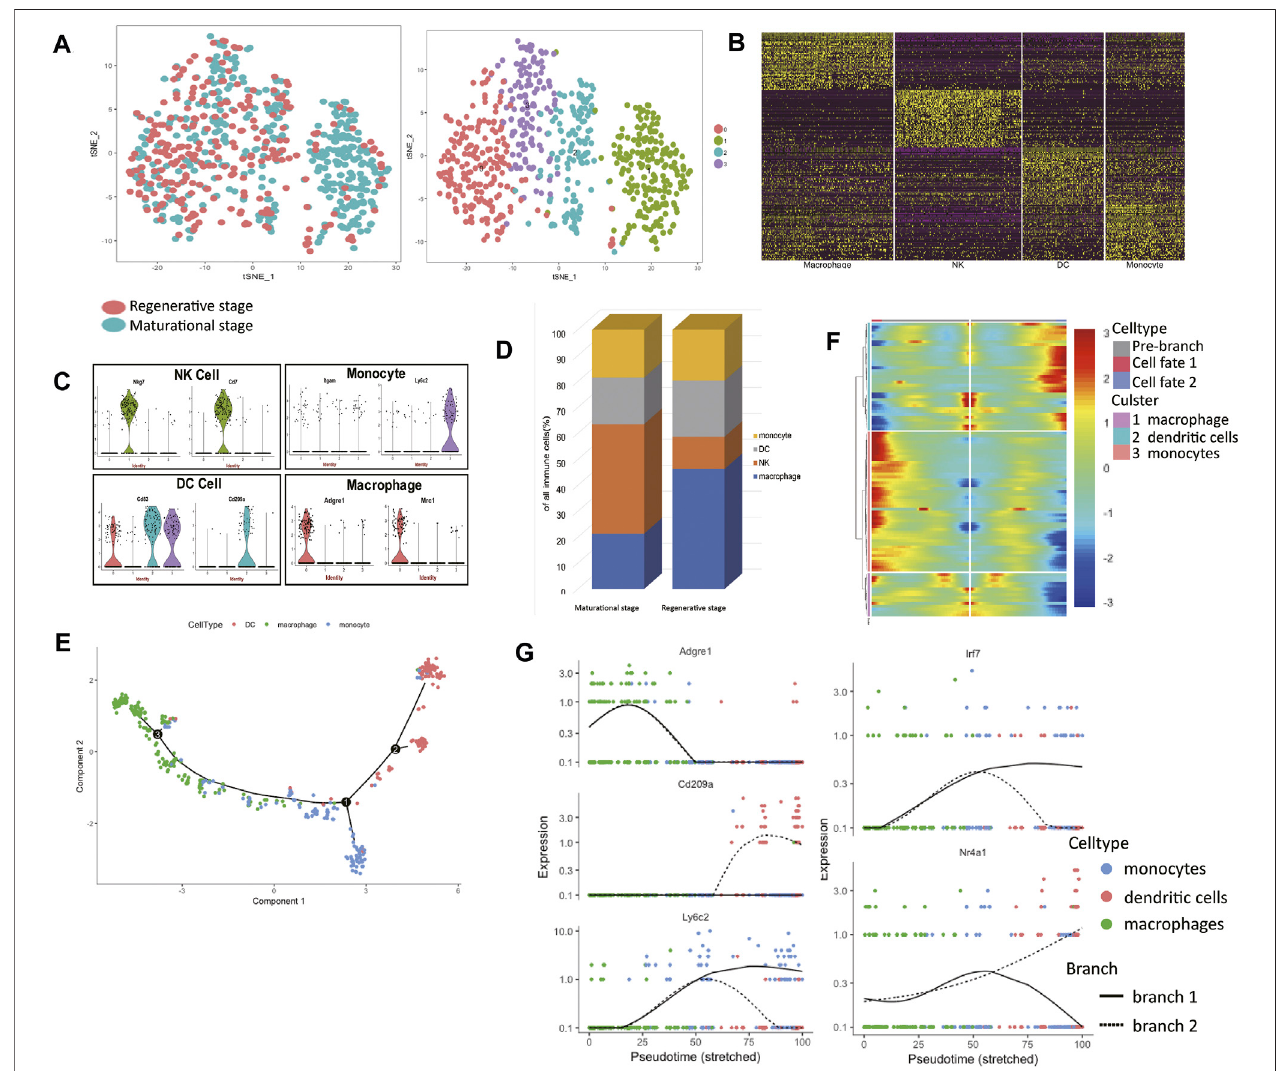
FIGURE4| Theimmunelandscapeoftheuterusduringthetwoestrusstages. (A) t-distributedstochasticneighborembedding(t-SNE)diagramofimmunecellsin two mice uteri. (B) Heatmap of immune cells from the two uteri revealed four populations. (C) Violin plots indicating the expression of marker genes of each cell cluster. (D) The immune cell composition of the two uteri was different, macrophages dominated in the regenerative stage, while natural killer (NK) cells dominated in the maturational stage. (E) Monocle generated the pseudotemporal trajectory of the phagocyte system. (F) Heat map for clustering the signi fi cantly branch-1 dependent genesthataffectedcellfate decisions into threeclusters.q < 1E-06. (G) The expression levels ofrepresentative genesofmacrophages/dendritic cells(DCs)/ monocytes and three transcription factors were shown in the line plots. t-SNE: t-distributed stochastic neighbor embedding; NK: natural killer; DC: dendritic cells.